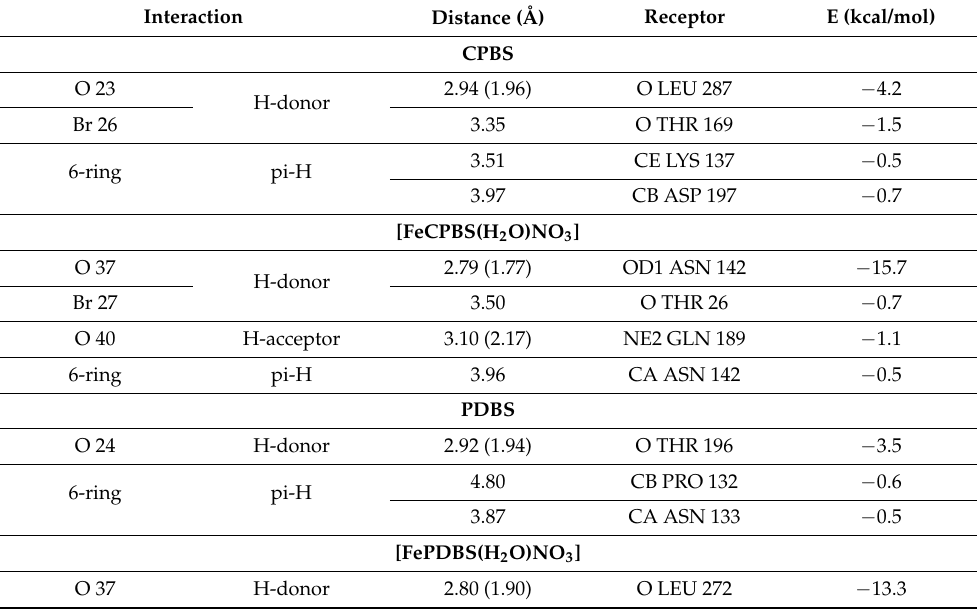
Table 3. The docking of PDBS, CPBS, (FePDBS (H2O) NO 3 ), and (FeCPBS (H 2 O)NO 3 ) with the active sites of the COVID-19 major protease viral protein receptor was studied (PDB ID: 6lu7). Interaction Distance